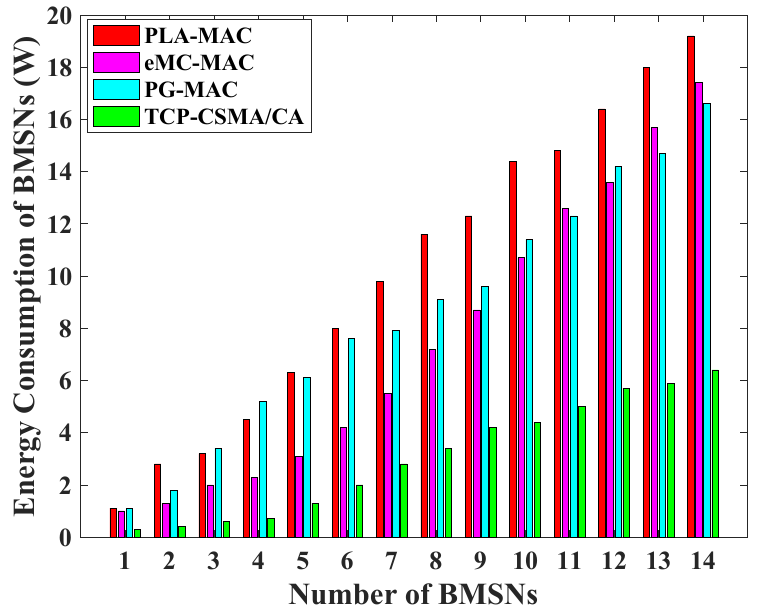
Figure 6. BMSNs energy consumption versus number of BMSNs